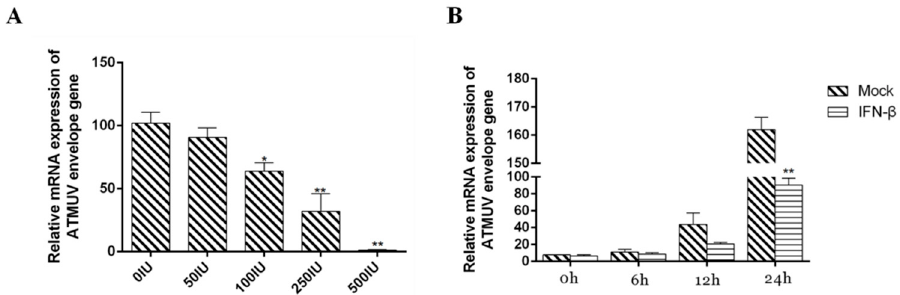
Figure 11. IFN significantly impairs DTMUV replication in dose- and time-dependent manners. ( A ) DEF cells were incubated with avian IFN- β ranging from 50 to 500 IU/mL after infection with DTMUV for 36 h. qRT-PCR was performed to examine DTMUV envelope gene expression. ( B ) DEF cells were incubated with avian IFN- β (500IU/mL) for 0, 6, 12, or 24 h following infection with DTMUV at for 36 h. qRT-PCR was performed to examine DTMUV envelope gene expression. The error bars represent the SEs. * P < 0.05, ** P < 0.01.